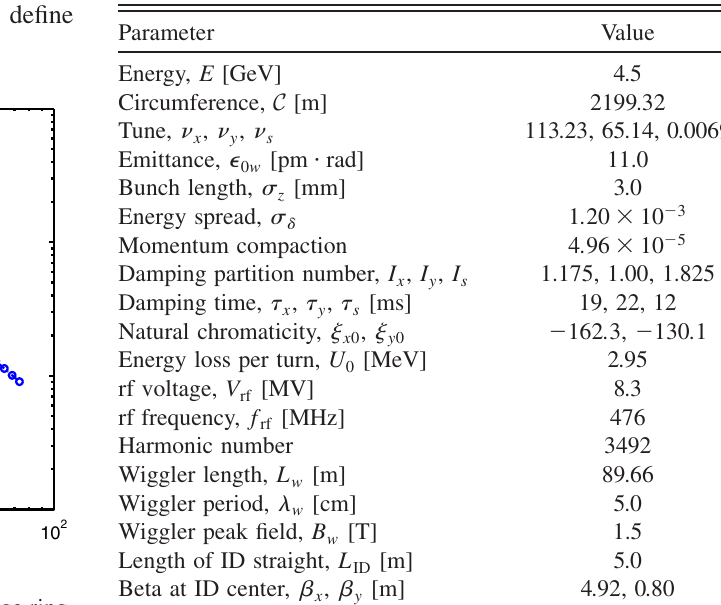
TABLE II. PEP-X lattice parameters with damping wigglers at zero beam